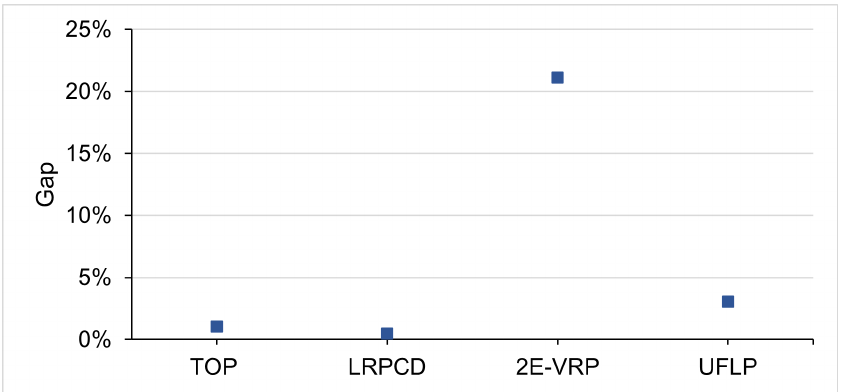
Figure 9. Absolute gap difference between BFS and AOS for the selected problems with respect to the